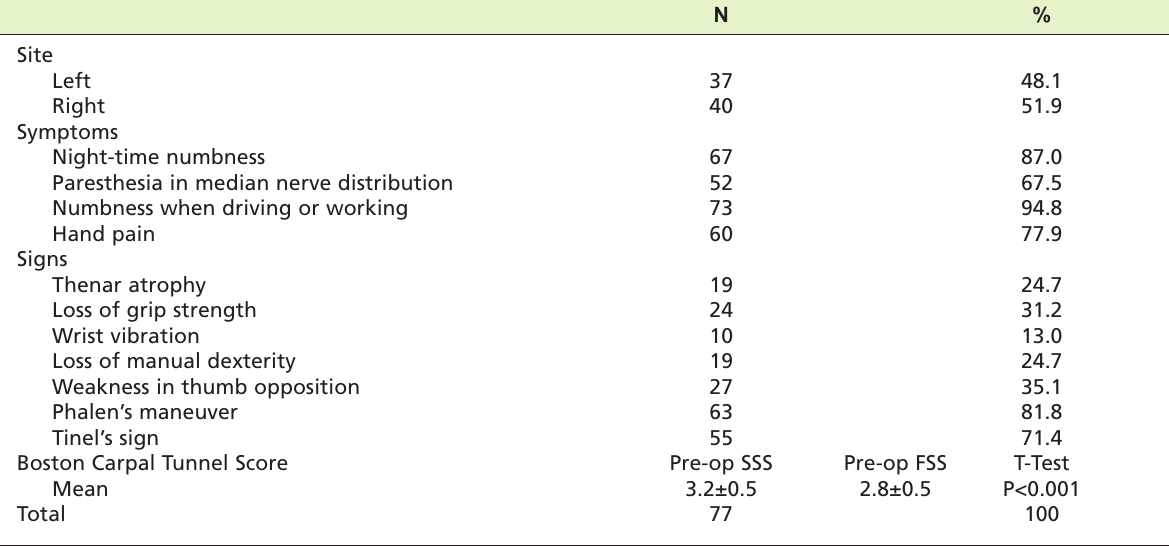
Pre-operative characteristics Table II: